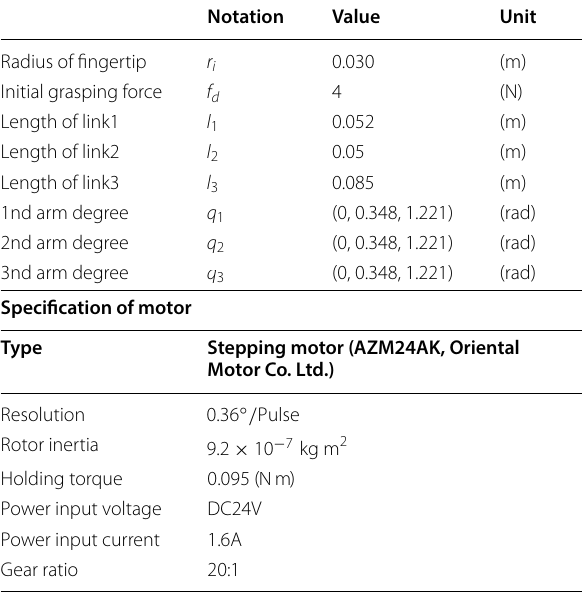
Table 4 Parameters of the prototype of the robotic hand used in the